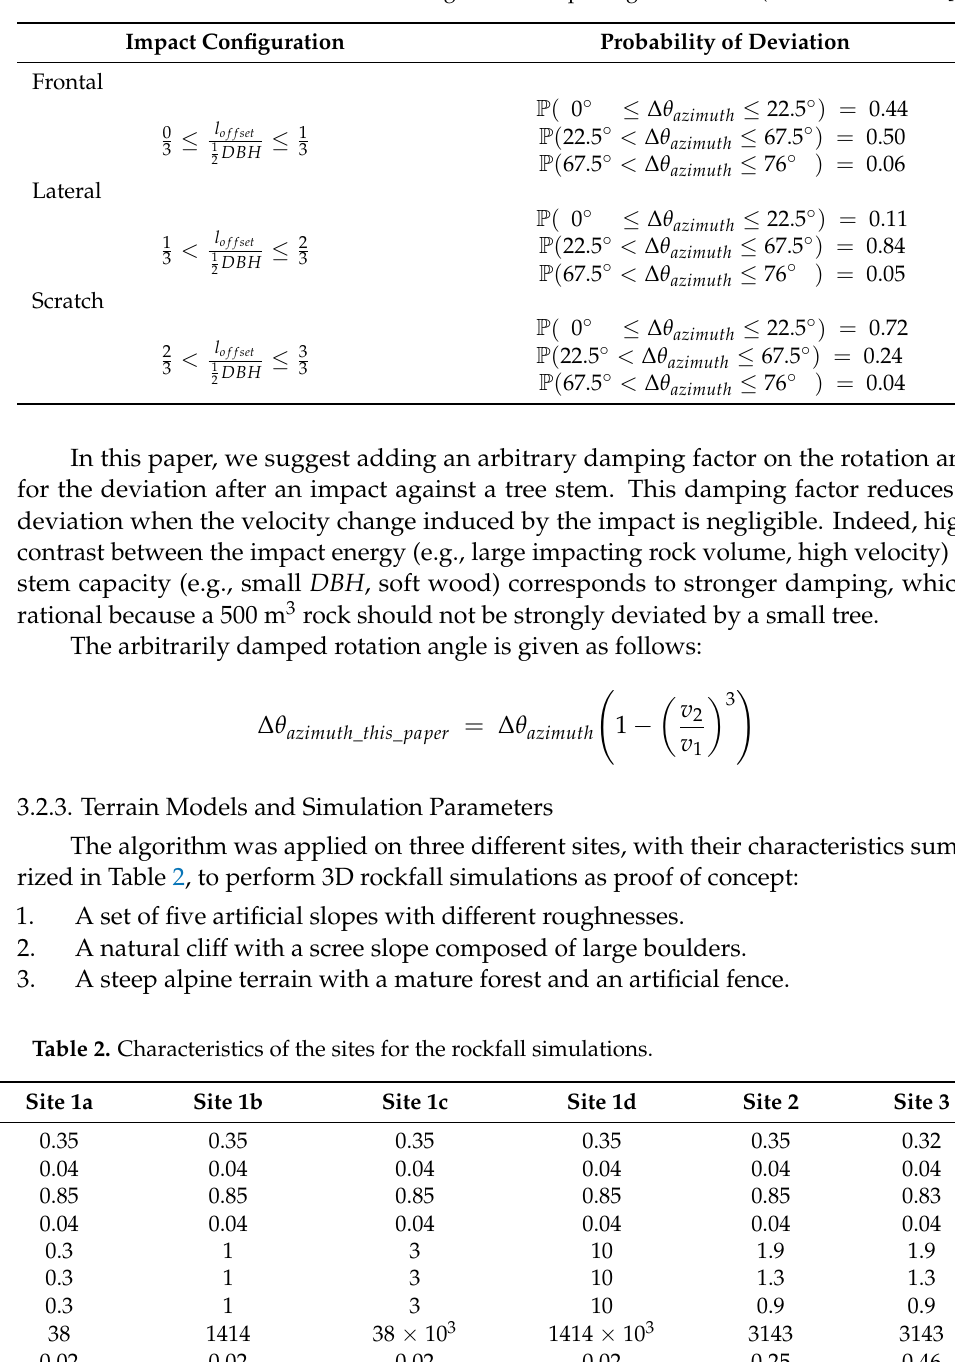
Table 1. Probabilities for deviation occurring after an impact against a stem (after Dorren et al. [49]).